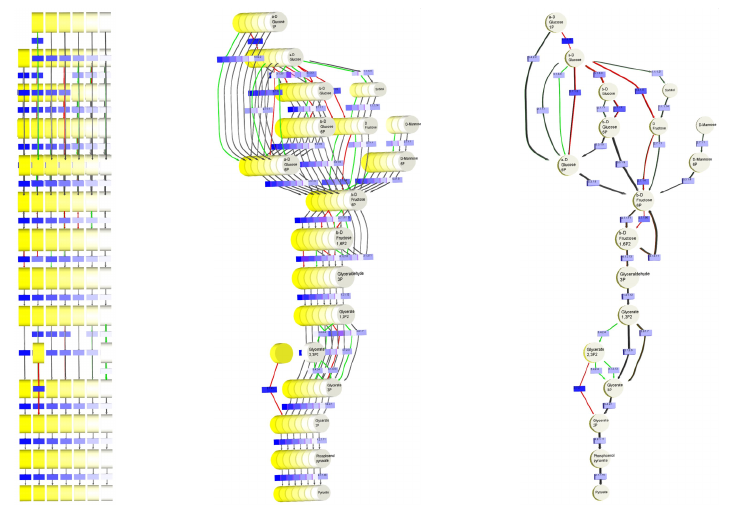
Fig. 6. 2 1/2D drawing of seven related pathways (parallel projection).